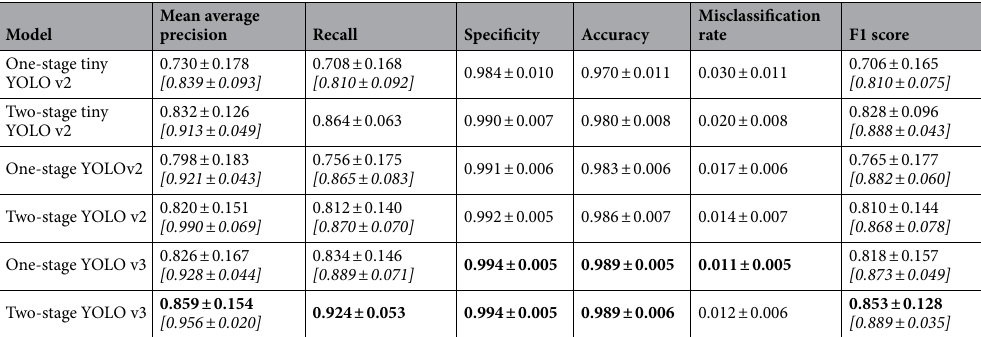
Table 2. Model-wise identification performance of the YOLO networks. Performance metrics analyzed represent the value and its 95% confidence interval. The adjusted values [italics characters in brackets] were calculated when the response value was less than 50%; this may bias the results toward the classes with small values. Bold value represents the highest value of the proposed statistical parameters by